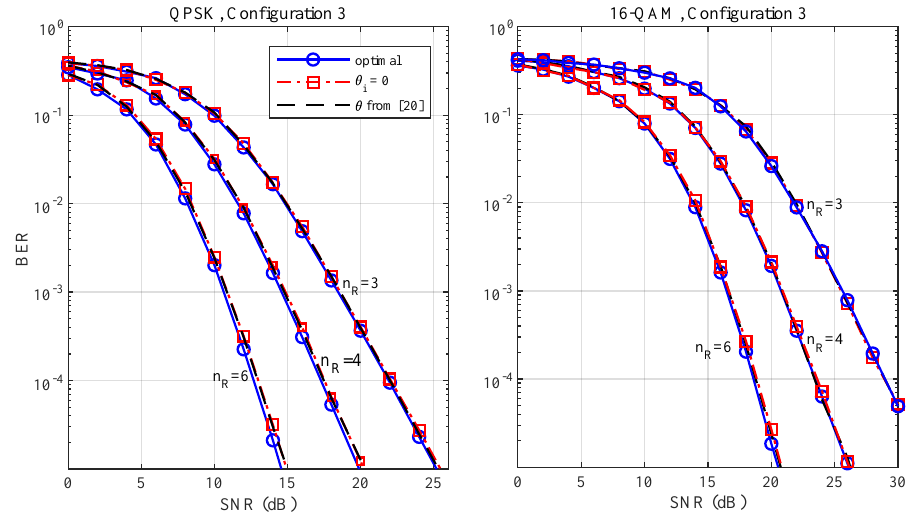
Figure 5. BER of MA-SM using the optimal rotation angles, the angles derived in [20], and the all-zero angle set, for N T = 5, N P = 3, n R = 3, 4, and 6, using QPSK ( left sub-figure ) and 16-QAM ( right-sub-figure